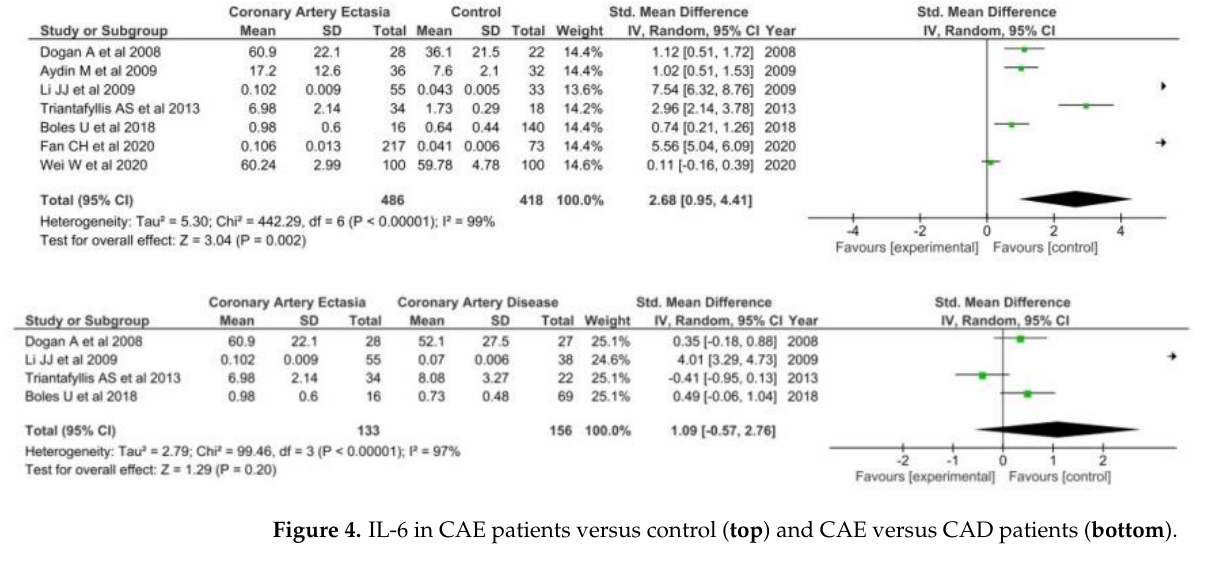
Figure 4. IL-6 in CAE patients versus control ( top ) and CAE versus CAD patients ( bottom ).